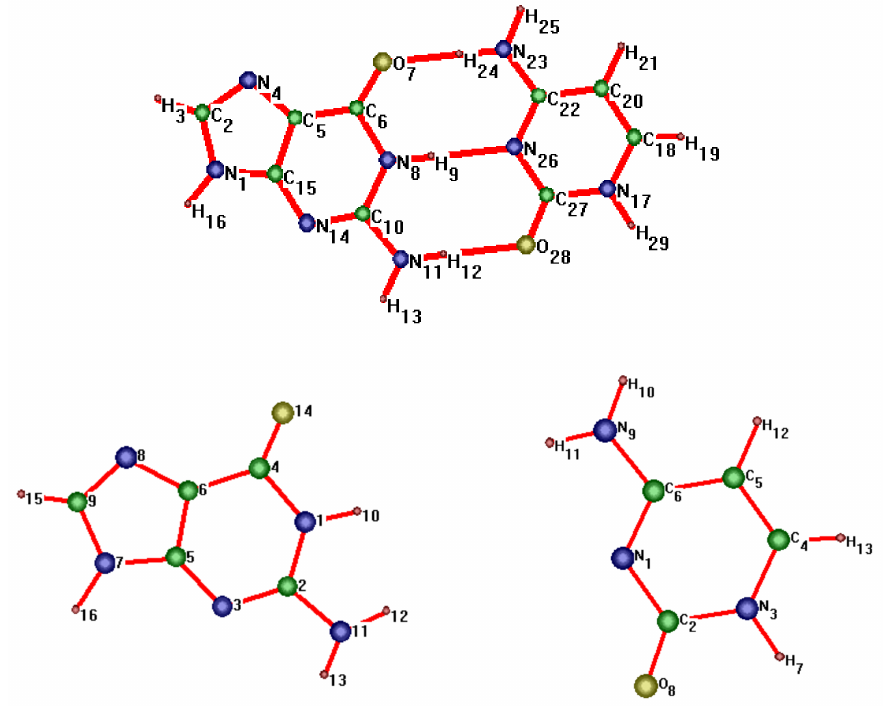
Figure 3. Cytosine-guanine pair ( top ) and separate molecules ( bottom